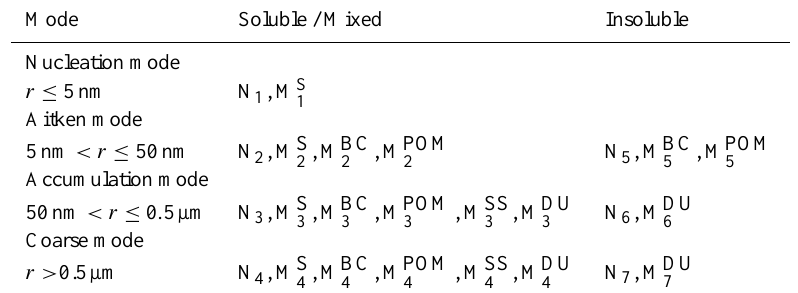
Table 1. The modal structure of HAM-M7. N i denotes the aerosol number of mode i and M j radius r shows the limits of different modes (Stier et al. (2005)).